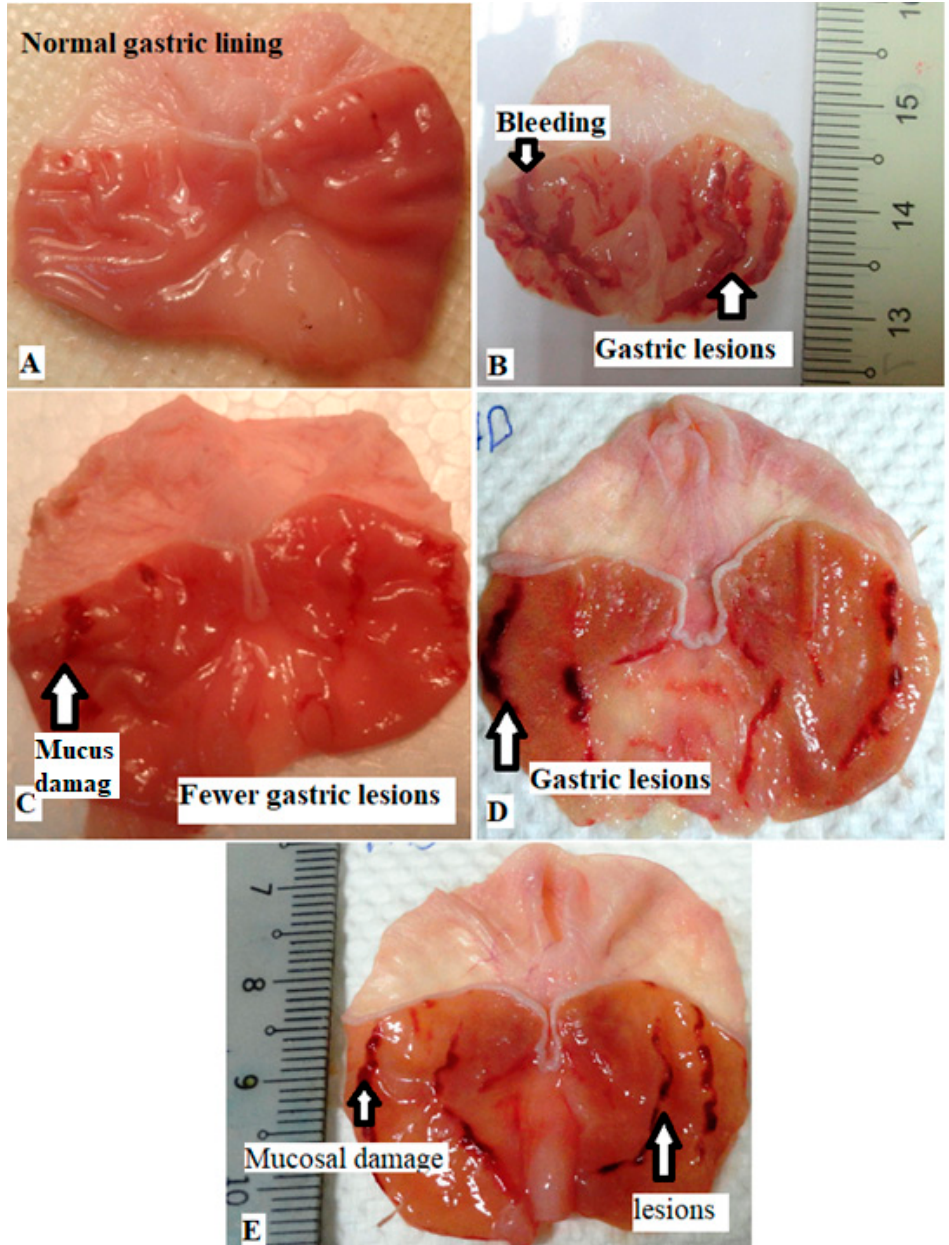
Figure 3. Influences of the PDE on the gross appearance of the stomach mucosa obtained from the ethanol ‐ induced ulcerogenic rats. ( A ), normal control; ( B ), ulcer control; ( C ), reference rats (omeprazole, 20 mg/kg); ( D ), rats received 200 mg/kg of the PDE; ( E ), rats received 400 mg/kg of the PDE.